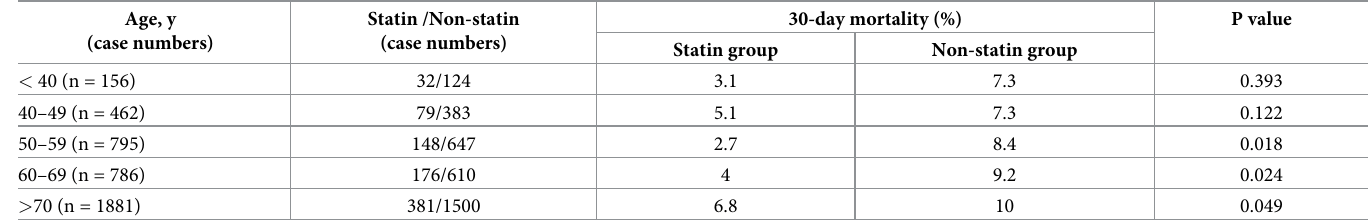
Table 5. The age of 30-day mortalities for the statin group and non-statin